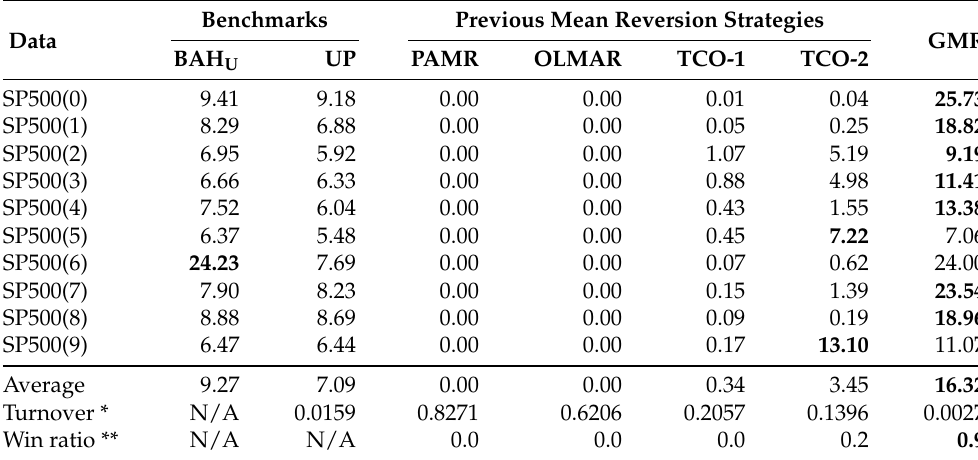
Table 4. Cumulative wealth achieved by various strategies on the S&P 500 datasets. The transaction cost rate was 0.25%. The best values are shown in